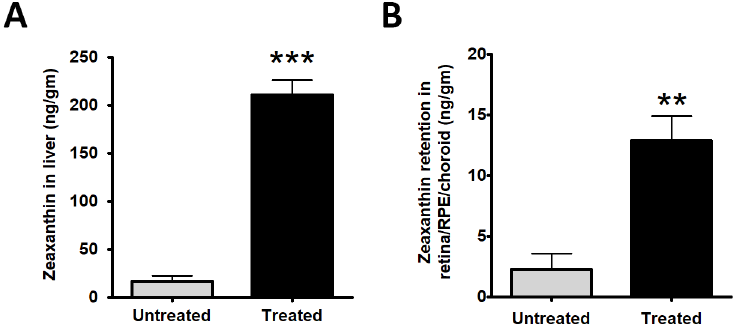
Fig 1. Zeaxanthin retention. The experimental group (n = 3) received daily gavage feeding of zeaxanthin beadlet at a dosage of 55-60mg/kg body weight for one month resulted in 12-fold retention of zeaxanthin in liver (n = 3) (A) and 5-fold retention in retina/RPE/choroid (n = 4) (B) compared to control untreated group (n = 3) on normal diet (Unpaired t-test, two tailed (cid:3)(cid:3) P < 0.01 and (cid:3)(cid:3)(cid:3) P <